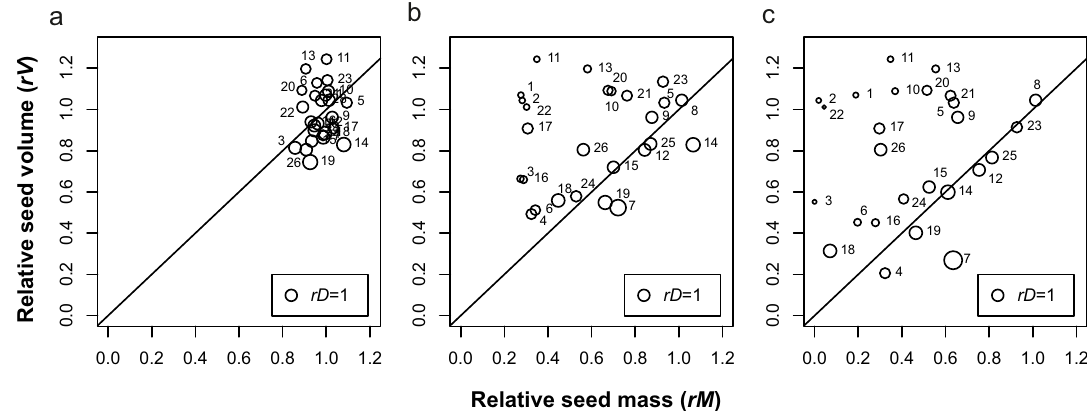
Figure 2. Interrelationship between relative mass ( rM ), volume ( rV ) and density ( rD ) of 26 species of seeds (for species codes, see Table 1). Fitted values from the best models shown in Figures a, b, and c were used, the line of slope = 1 indicates the situation when relative mass and volume declined at the same rate so rD did not change. Sizes of the symbols are scaled according to the size of change in rD , the symbol size shown on the bottom right equals rD = 1, smaller or larger symbols refer to proportional decrease or increase in rD , respectively. ( a ) YAB 1 ; ( b ) YAB 5 ; ( c ) YAB 8.